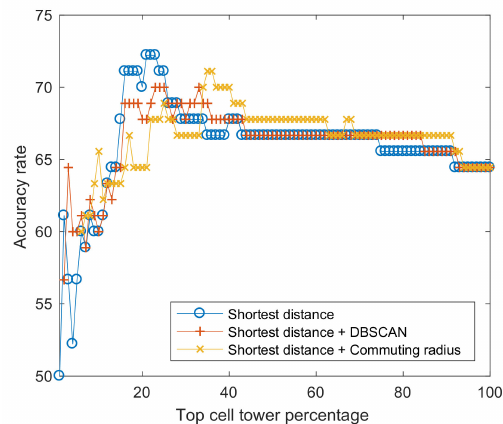
Figure 20. Results of the shortest distance-based methods with and without noise filtering.